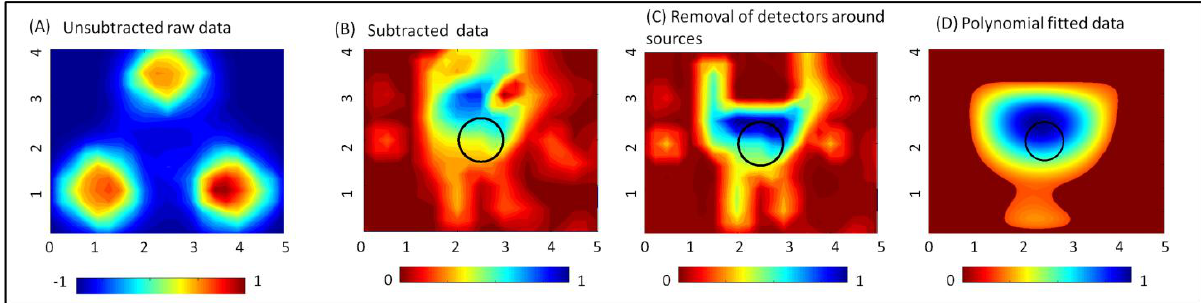
of the implemented post-processing techniques: ( A ) unsubtracted raw data, ( B ) subtracted data, ( C ) data after removal of detectors around the sources, and ( D ) 5th degree polynomial fitted data. The sample data shown here is for experimental reflectance data using a 0.45 cc target located 1.5 cm